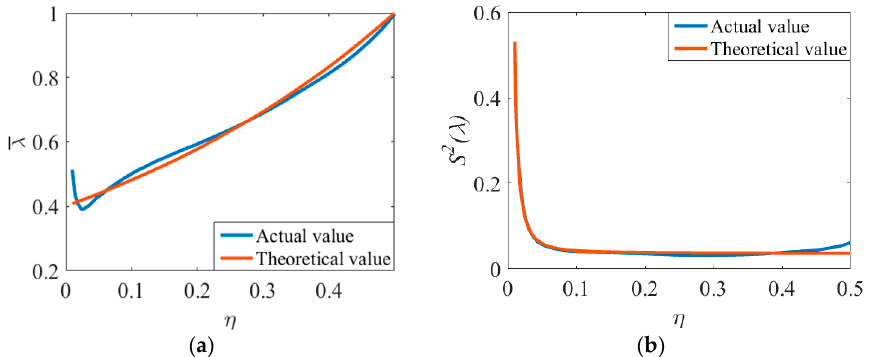
Figure 5. Mean and variance of the relative compression ratio and total compression ratio: ( a ) Mean; ( b ) Variance.